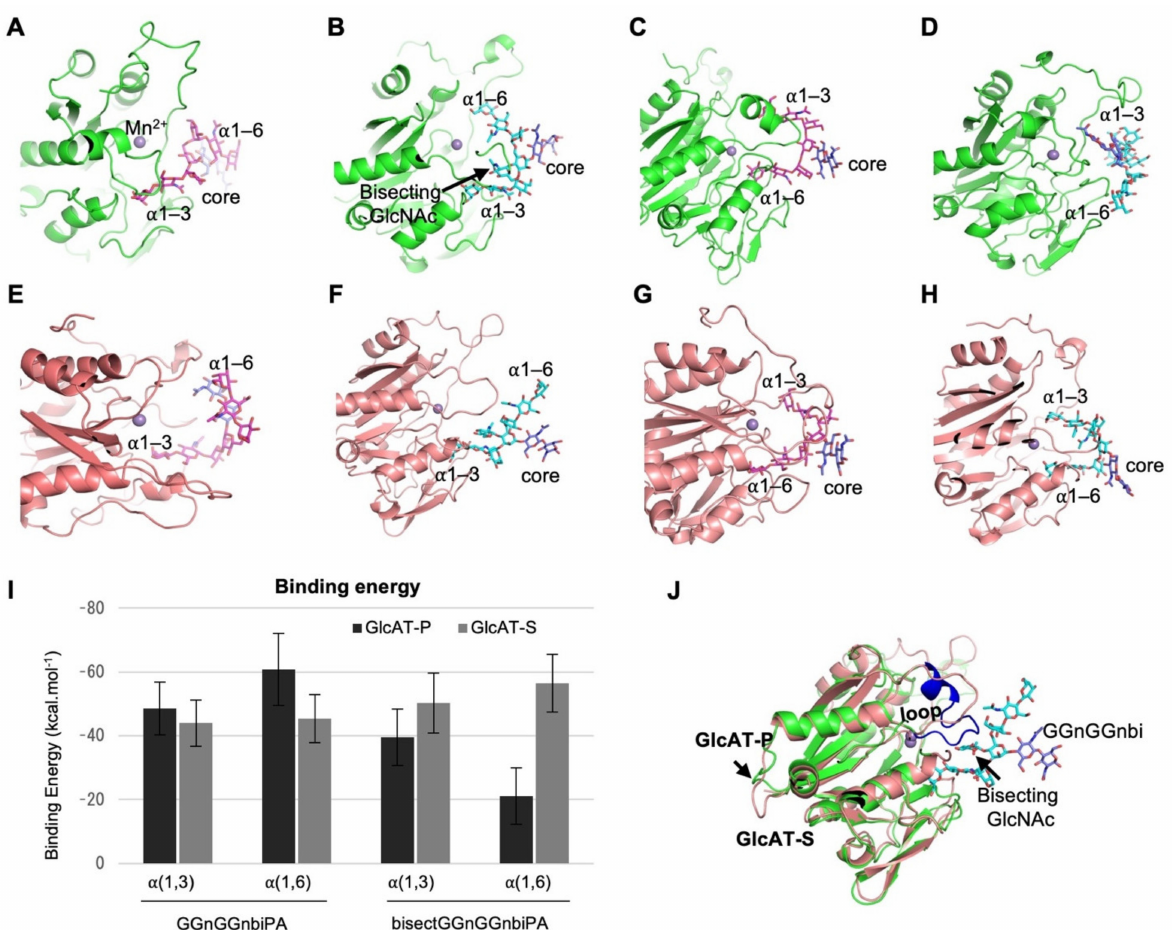
Figure 4. MD simulation of the binding of GlcATs and the N -glycans with or without bisecting GlcNAc. ( A – H ) Binding modes of non-bisected (GGnGGnbi, magenta) and bisected (bisectGGnGGnbi, cyan) biantennary N -glycans in GlcAT-P (green) and GlcAT-S (pink). The chitobiose core is colored in blue. These binding modes have been taken from the most populated conformation representative structure during 100 ns MD simulation. ( I ) The binding energy of bisectGGnGGnbi and bisectGGnGGnbi binding to GlcAT-P and GlcAT-S in kcal · mol − 1 . α (1,3) and α (1,6) indicate that this particular branch of N -glycan was kept in the reactive site, whereas the other branch was outside it. ( J ) Structures of GlcAT-P (green) and GlcAT-S (pink) superimposed on each other. The R142–I155 loop in blue occupies the position of bisecting GlcNAc in